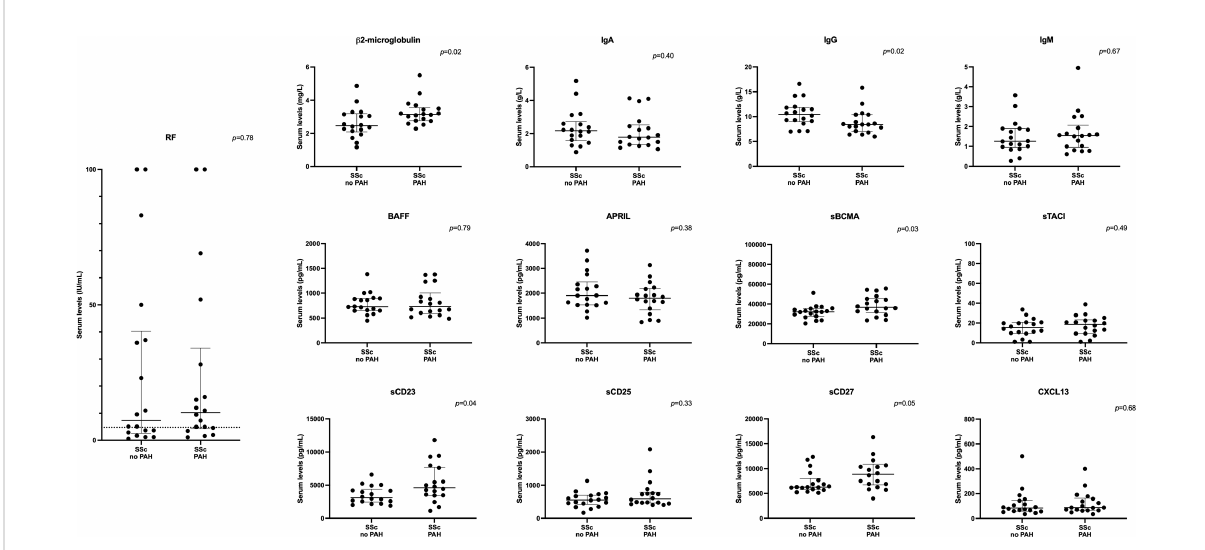
FIGURE 3 Serum levels of soluble markers of B cell activation in SSc patients with and without PAH (validation cohort). APRIL, a proliferation-inducing ligand; BAFF, B-cell-activating factor; BCMA, B-cell maturation antigen; CD, cluster of differentiation; CXCL13, C-X-C motif chemokine 13; HC, healthy controls; Ig, immunoglobulin; PAH, pulmonary arterial hypertension; RF, rheumatoid factor; s, soluble; SSc, systemic sclerosis; TACI, transmembrane activator and CAML interactor. The dotted line on the RF panel represents the threshold for RF positivity. Error bars display means and standard